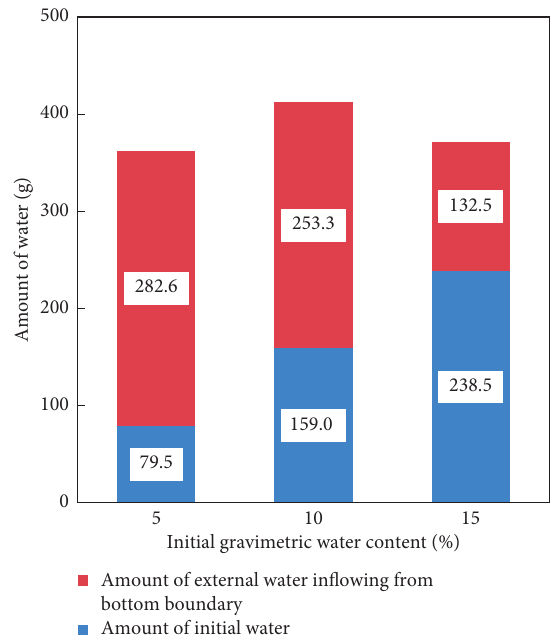
Figure 12: Amount of water in samples of different initial water content.